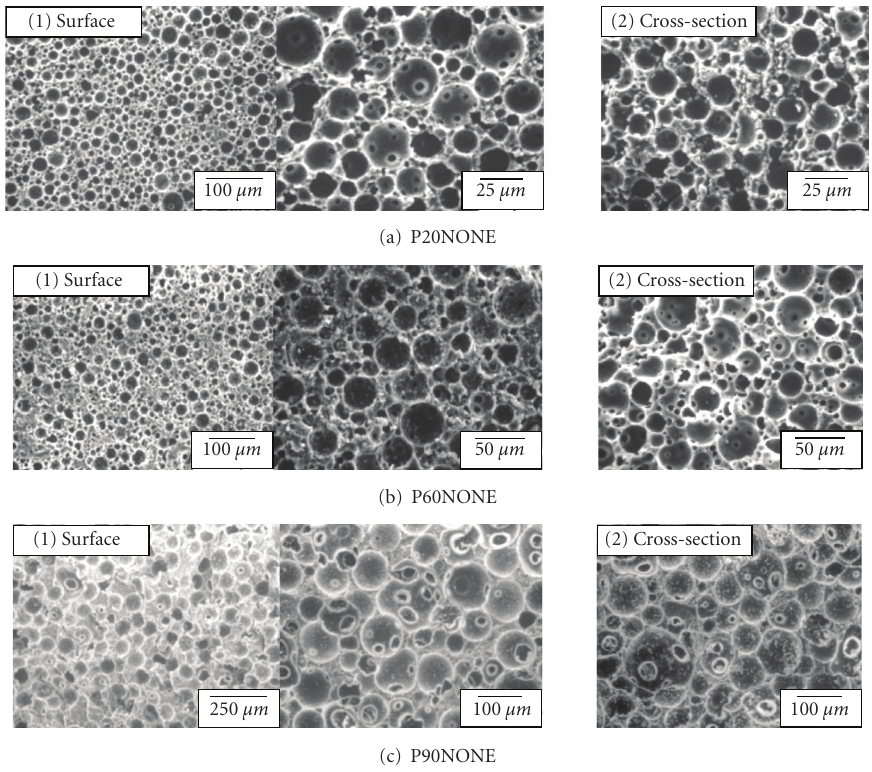
Figure 1: SEM photographs of (a) P20NONE, (b) P60NONE, and (c)